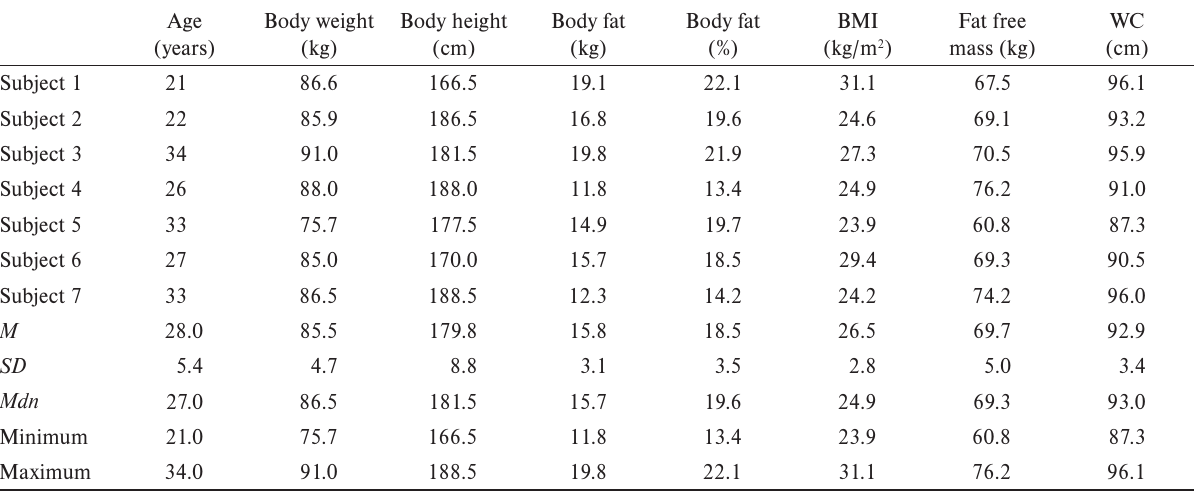
Anthropometric characteristics